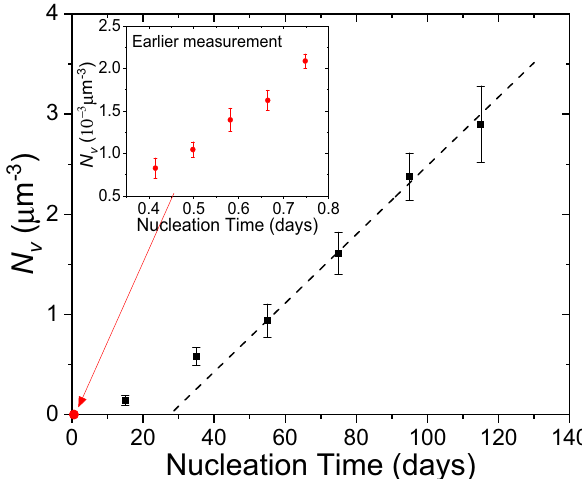
Fig. 1 The scaled nucleation barrier as a function of temperature for silicate glasses. These data are from the literature and for the following glasses: 44Na 2 O ∙ 56SiO 2 (N44S56) 8,16 , Li 2 O ∙ 2SiO 2 (LS2) 8,11 , BaO ∙ 2SiO 2 (BS2) 10 , 5BaO ∙ 8SiO 2 (B5S8) 10 , and x Na 2 O ∙ (50- x )CaO ∙ 50SiO 2 (NCS) where the x -values are 33.3 8,15 , 24.4 7,13 , 22.4 7,13 , 21.3 7,13 , 19.2 7,13 , and 16.7 8,12 – 14 , respectively. The solid lines serve as guides to the eye. (Reproduced from refs. 7,8,10 with permission from Elsevier.)